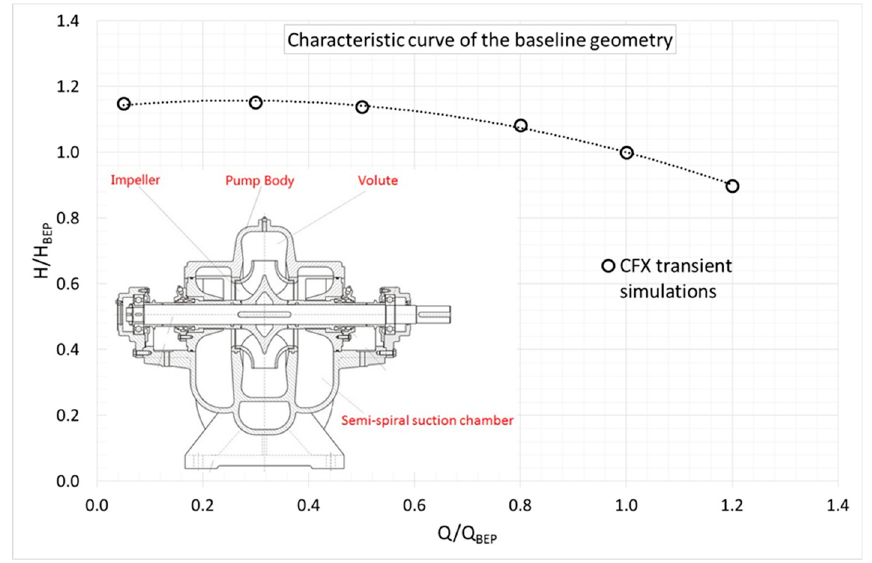
Figure 13. Characteristic curve of the commercial pump calculated by means of numerical simulations with CFX and 40 million of cells.